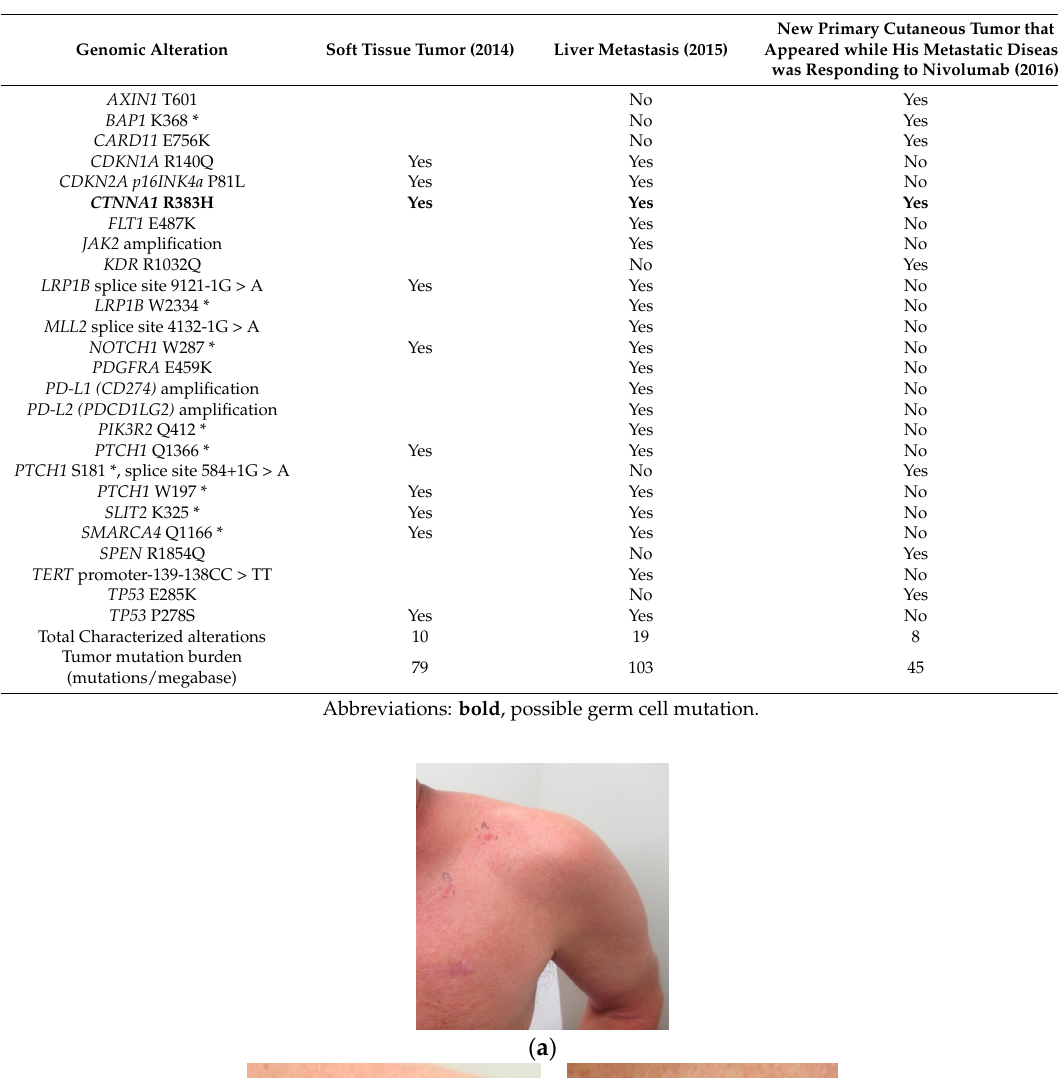
Table 1. Genomic aberrations of patient’s basal cell carcinomas.